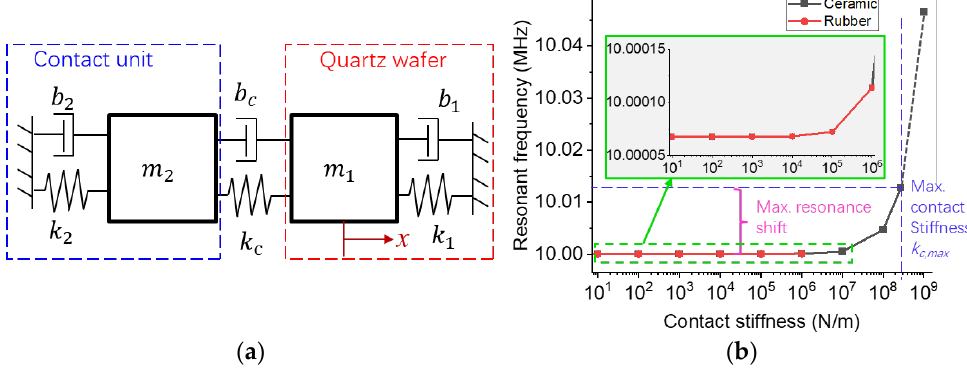
Figure 2. The effective model of a BAW strain sensor. ( a ) A dual mass-spring-damper model. ( b ) The influence of the effective contact stiffness on the resonance of the quartz.